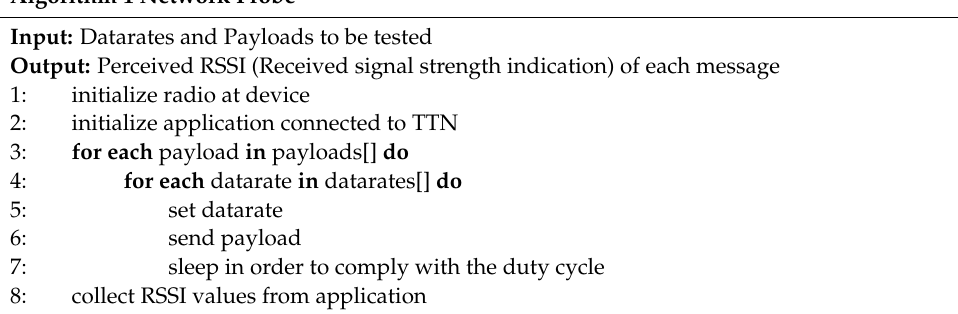
Figure 14. LoRa probe installed on top of an Iglô. Algorithm 1 Network Probe